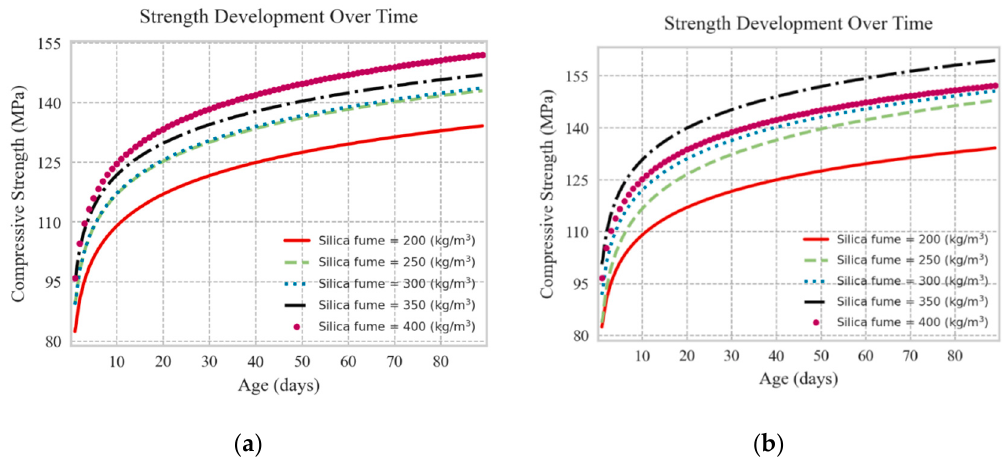
Figure 9. Strength development of UHPC mixtures over time; ( a ) cement content: 750 kg/m 3 , and ( b ): cement content 1000 kg/m 3 .